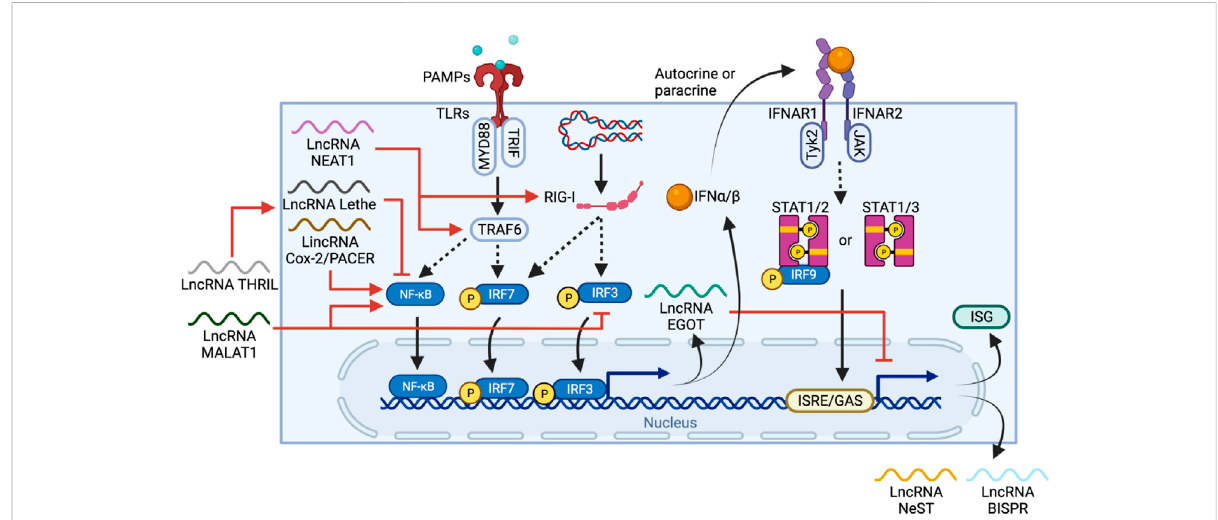
FIGURE 5 LncRNA regulation and feedback loops in IFN-I production and ISG expression. PAMPs or foreign nucleic acid are sensed by TLRs and RIG-I, respectively. The TLR pathway activates IRF6 and NF- κ B through TRAF6, whereas RIG-I activates IRF3/7 directly, leading to their nuclear translocation and IFN-I expression. IFN-I can then stimulate IFNAR in either autocrine or paracrine manners to trigger a STAT1/2/3-mediated pathway, promoting ISG expression. LncRNAs regulate one or more elements in the IFN-I production cascade, including activation of TRAF6 and RIG-I by NEAT1, activation of NF- κ B by MALAT1 and PACER, or inhibition of NF- κ B by THRIL and Lethe. EGOT forms a negative feedback loop, itself is induced by TLR and RIG-1 pathways but also regulates IFN-1 induced responses by inhibiting the expression of ISG and other anti-viral lncRNAs such as NeST and